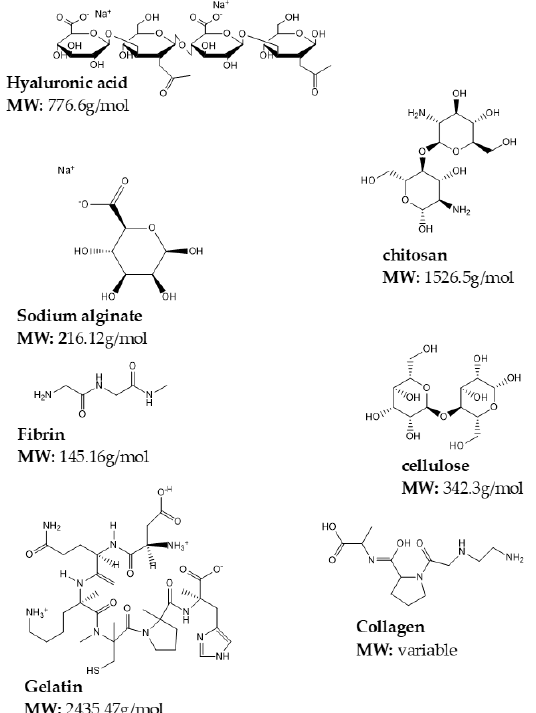
Figure 3. Chemical structures and molecular weights (MW) of naturally derived polymers used in the manufacture of cross-linked